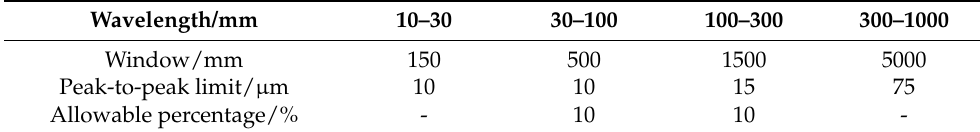
Table 2. The evaluation criteria of the European Railway Union.